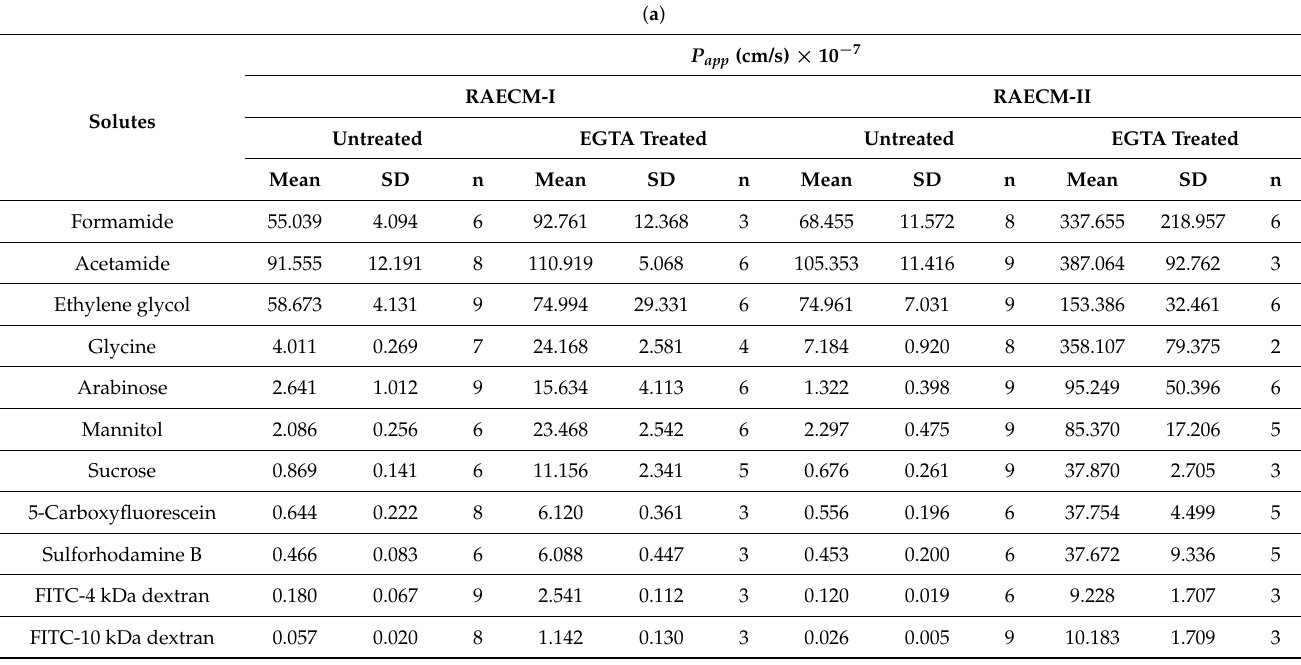
Comparison of the benzyl alcohol P app across RAECM-I and that across RAECM-II or comparison of unstirred layer thickness of RAECM-I and that of RAECM-II shows no statistical difference. P app (after correction for the unstirred layer effects) of the solutes across RAECM-I or -II, without and with 2 mM EGTA, in the apical-to-basolateral direction are listed in Table 3a. As expected, P app decreases with increased solute molecular weight. Significant differences in P app of solutes across RAECM-I (or -II) without and with EGTA were observed (Table 3 and Tables A1 and A2 in Appendix A). Table 3. P app across RAECM-I and RAECM-II with statistical analyses. ( a ) P app across RAECM-I and RAECM-II in the absence and presence of EGTA corrected for unstirred layer effects. ( b ) and ( c ) Three-way analysis of variances (ANOVA) of P app across RAECM-I and -II (with or without EGTA). Three factors assigned for three-way ANOVA are as follows: “different solutes”, “wo vs. w EGTA”, and “RACEM-I vs. RAECM-II” with alpha being set at 0.05, where w = with, wo = without, × = interaction between factors, and DF = degree of freedom. Results suggest that there are significant differences between P app across RAECM-I and those across RAECM-II, significant effects of EGTA treatment on P app for both RAECM-I and RAECM-II, and P app for different solutes in each experimental setting are statistically significant (all at p < 0.0001). ( c ) Summary table of three-way ANOVA for the source of variation, % of variation, p value, p value summary, and significance vs. no significance. SS (sum of square), DF (degree of freedom), MS (mean